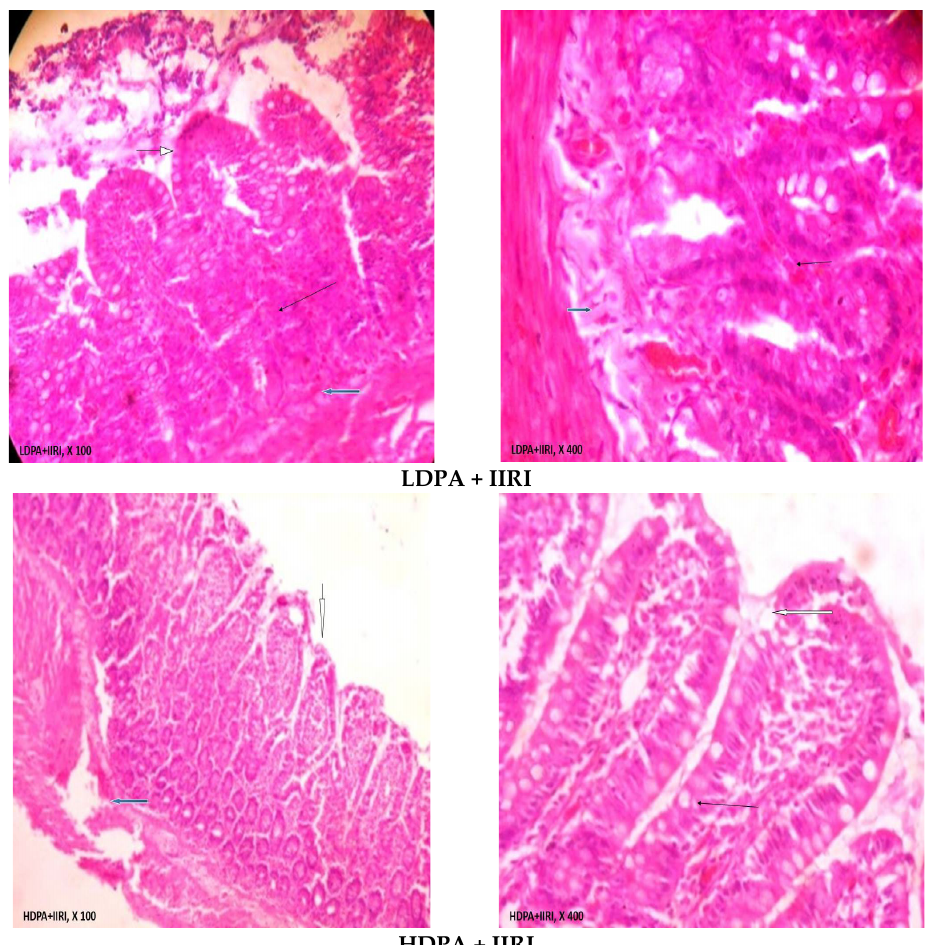
Figure 5. Effect of intestinal ischemia/reperfusion (I/R) and methanolic Phyllanthus amarus leaf extract on intestinal histoarchitecture. IIRI: intestinal ischemia/reperfusion injury, FEB: febuxostat, LDPA: low-dose Phyllanthus amarus , HDPA: high-dose Phyllanthus amarus. The sham-operated an- imals showed normal villi from the mucosal layer (white arrow). The lumen showed moderate lymphocyte infiltration, while the propria showed moderate inter-glandular infiltration of inflam- matory cells (slender arrow), and the submucosal layer was moderately infiltrated by inflammatory cells (blue arrow). Animals in the IIRI group showed a chronically inflamed mucosal layer with sloughed and inflamed villi (white arrow). The lumen showed infiltration of lymphocytes, poly- morphs, and plasma cells involving the propria and glands (slender arrow), while the submucosal layer was severely infiltrated by inflammatory cells (blue arrow). Rats in the FEB + IIRI group showed moderately preserved villi from the mucosal layer (white arrow). The lumen showed se- vere lymphocyte infiltration; the propria showed severe inter-glandular infiltration of inflammatory cells (slender arrow); the submucosal layer appeared normal (blue arrow). Rats in the LDPA + IIRI showed moderately preserved villi from the mucosal layer (white arrow). The lumen showed mild lymphocyte infiltration; the propria showed mild inter-glandular infiltration of inflammatory cells (slender arrow); the submucosal layer appeared normal (blue arrow). The animals in the HDPA + IIRI showed normal villi from the mucosal layer (white arrow). The lumen showed mild lymphocyte infiltration; the propria showed mild inter-glandular infiltration of inflammatory cells (slender arrow); the submucosal layer appeared normal (blue